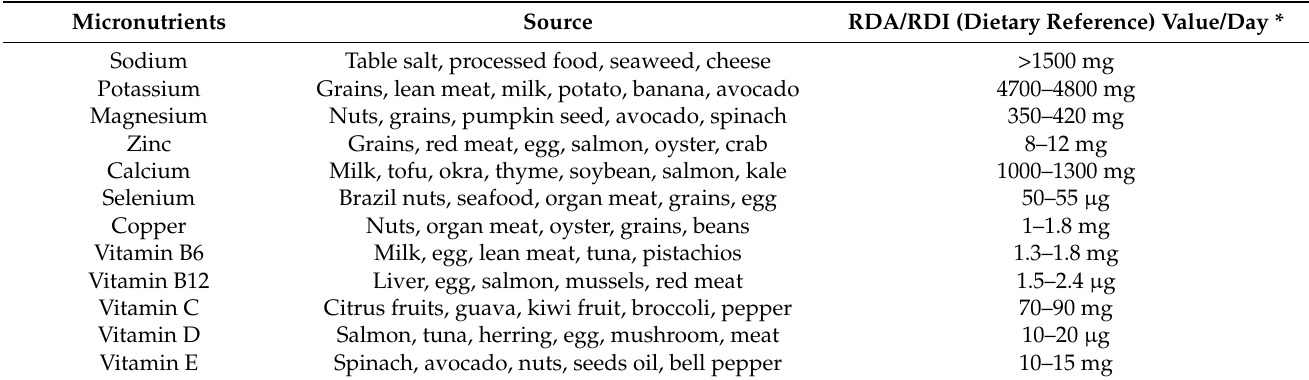
Figure 1. Imbalanced micronutrients (Na + , K + , Ca 2+ , Mg 2+ , Zn 2+ , Cu 2+ , Se 2- and vitamin B6, B12, C, D, and E) and their sequential impact on blood pressure/hypertension. SNS—sympathetic nervous system; RAAS—renin-angiotensin-aldosterone system; Na + —sodium; K + —potassium; Ca 2+ —calcium; Mg 2+ —magnesium; Zn 2+ —zinc; Cu 2+ —copper; Se 2 − —selenium. Table 1. The major source and RDA value of various